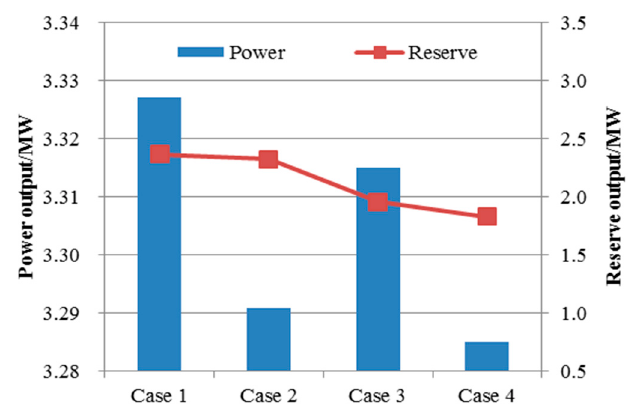
Figure 16. Power distribution of incentive-based demand response (IBDR) scheduling in various cases.